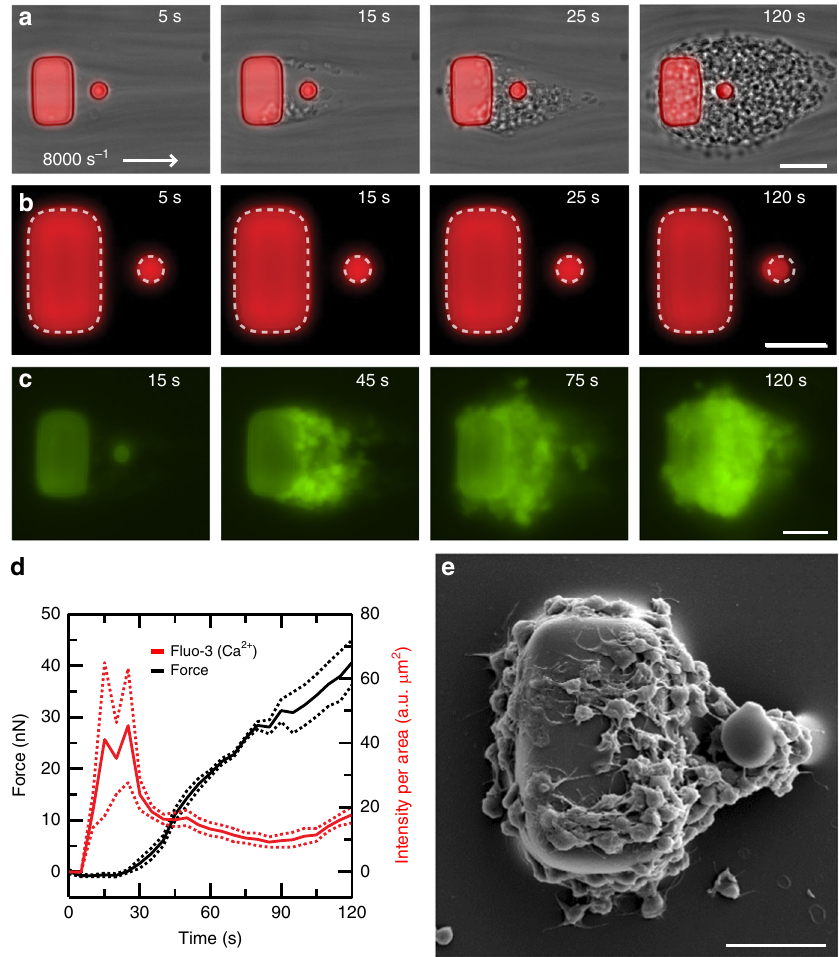
Fig. 2 Measurement of platelet forces coincide with platelet activation. a Representative time course of phase contrast and fl uorescence microscopy images taken during platelet aggregation at 8000 s − 1 . Platelets clump initially at the trailing edges of the block and then connect to the post, eventually recruiting more passing platelets to attach to the aggregate. Scale bar, 15 μ m. b The block and posts are fl uorescently labeled (red, DiI), which allows platelet forces to be measured by analyzing the de fl ection of the post over time. Multiple aggregates are measured in the same fi eld of view of the camera and averaged together over time to obtain a data trace. Scale bar, 10 μ m. c Using a fl uorescence indicator of Ca 2 + ( fl uo-3) shows that platelets exhibit increased intracellular calcium upon adhesion to the block. Scale bar, 10 μ m. d Representative data from a single donor shows that Ca 2 + concentration (red) increases prior to platelet forces on the posts (black). Solid lines indicate the mean and dashed lines indicate standard error of the mean. e Scanning electron microscopy (SEM) micrograph of a platelet aggregate formed after 45 s at 8000 s − 1 . Platelets attached to the block and post have undergone shear-induced activation and shape change. Scale bar, 10 μ